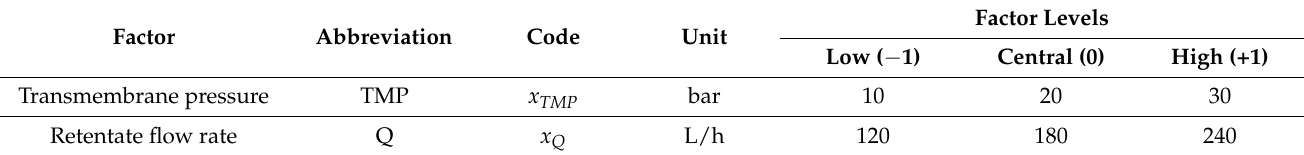
Table 2. The factors and levels of the 2 p full factorial experimental design.